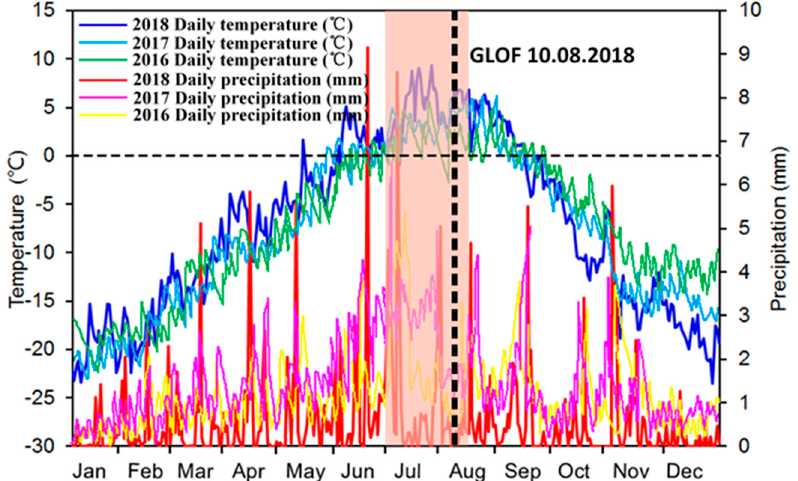
Figure 8. Daily 2 m temperature and total precipitation values for 2016–2018 for the Kyagar Glacier area taken from the European Centre for Medium-Range Weather Forecasts (ECMWF) model. The dashed line marks the glacial lake outburst flood (GLOF) in 2018 and the shaded rectangle marks the time frame covered by the observational data in this study.